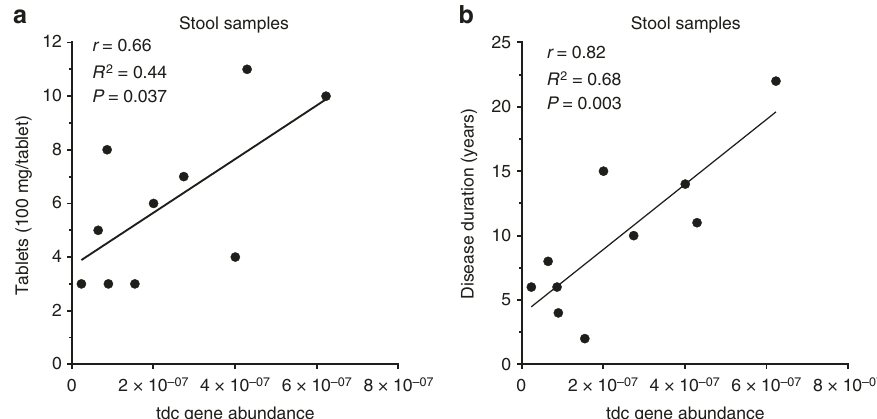
Fig. 5 Tyrosine decarboxylase gene abundance correlates with daily levodopa dose and disease duration in fecal samples of Parkinson ’ s disease patients. a Scatter plot of tdc gene abundance measured by qPCR in fecal samples of PD patients ( n = 10) versus daily levodopa/carbidopa dosage fi tted with linear regression model. b Scatter plot of tdc gene abundance from the same samples versus disease duration fi tted with a linear regression model. Pearson ’ s r analysis was used to determine signi fi cant correlations between tyrosine decarboxylase gene abundance and dosage ( r = 0.66, R 2 = 0.44, P value = 0.037) or disease duration ( r = 0.82, R 2 = 0.68, P value